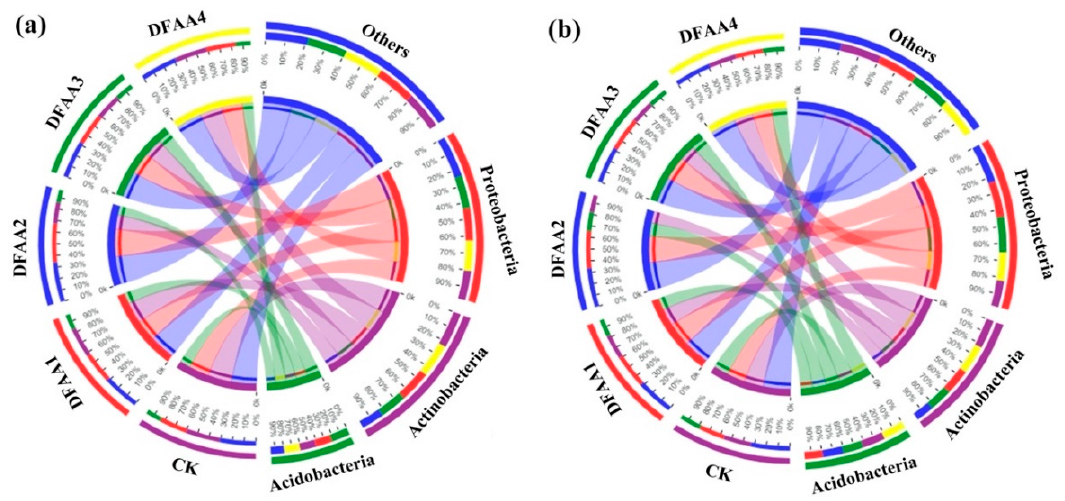
Figure 4. Circos diagram of different treatment samples and soil bacteria at phylum level after DFAA. ( a ) Soil layer of 0–20 cm; ( b ) soil layer of 20–40 cm. The small semicircle (left half circle) indicates the bacteria composition in the sample. The color of the outer ribbon represents the different treatments, from which the color of the inner layer is the species, and the length represents the relative abundance of the species in the corresponding treatment. The large semicircle (right half circle) indicates the proportion of species in different treatments at the phylum level. The outer ribbon represents the species, the inner ribbon color represents different treatments, and the length represents the proportion of the treatment in a certain species.